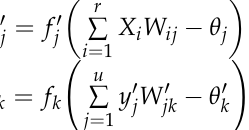
Table 6. Tuning parameters for the multilayer perceptron neural network